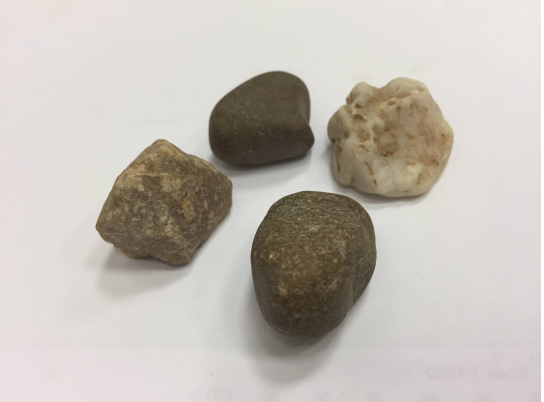
Figure 13. A selection of large particles extracted from a sample of Stanag soil, with masses of 10.41 g, 12.89 g, 9.70 g, and 15.11